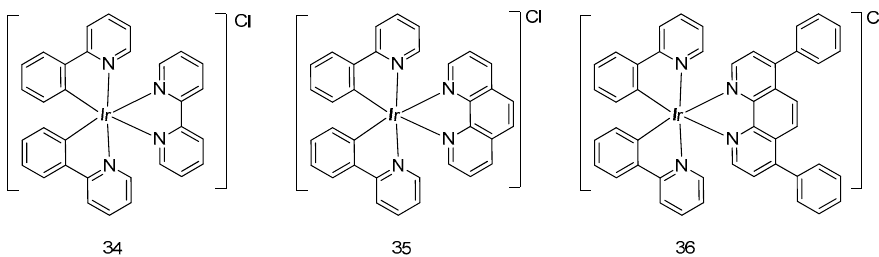
Figure 10. Cyclometalated octahedral iridium(III) compounds with 1-phenyl-pyridine C^N ligand and different N^N ligands.